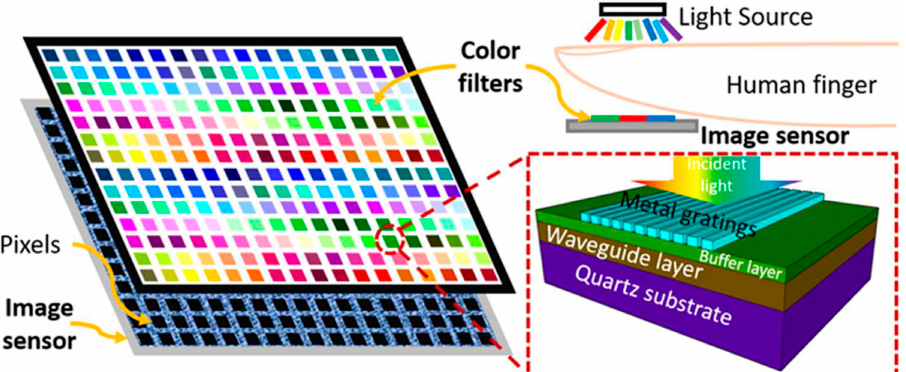
Figure 1. The schematics of the developed multispectral sensing system consisting of a broadband light source and an image sensor covered with color filter matrix ( top right ). Microscale filter matrix, which is based on a GMR filter architecture involving periodic gratings ( bottom right ), is set on top of image sensor ( left